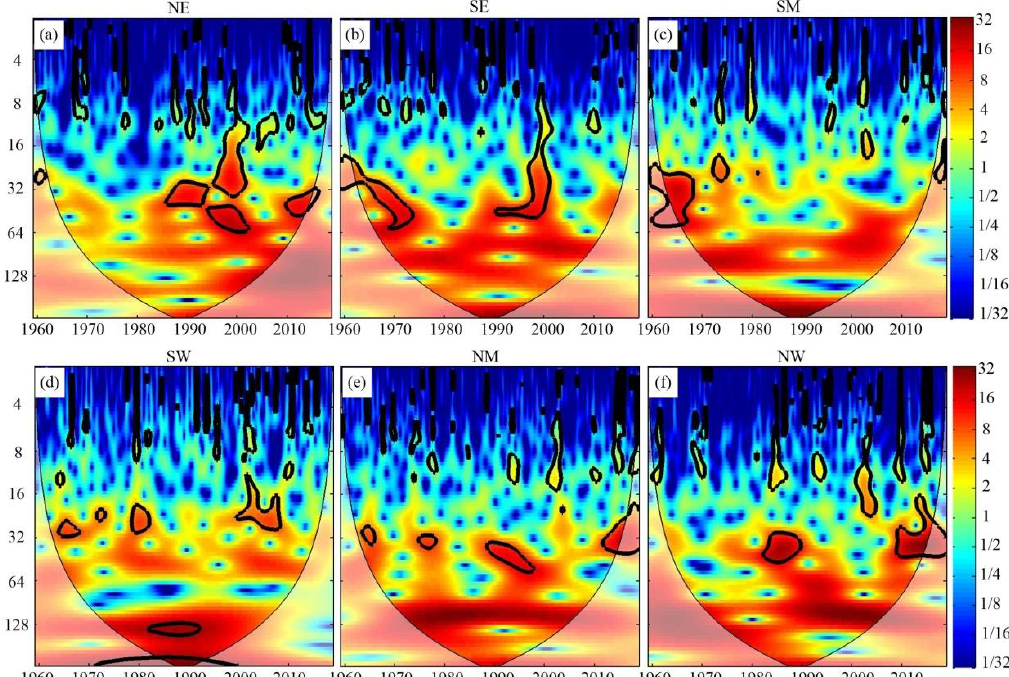
Figure 11. The power spectra of the continuous wavelet transform (CWT) of the monthly averaged scPDSI in the six sub-regions between 1959 and 2018. The change from red to blue indicates a decrease in the wavelet power. The cone of influence (COI) is represented by the light shade. The black contour is the local wavelet power relative to red noise with a 0.05 significance level threshold. ( a ) NE, ( b ) SE, ( c ) SM, ( d ) SW, ( e ) NM, ( f ) NW.